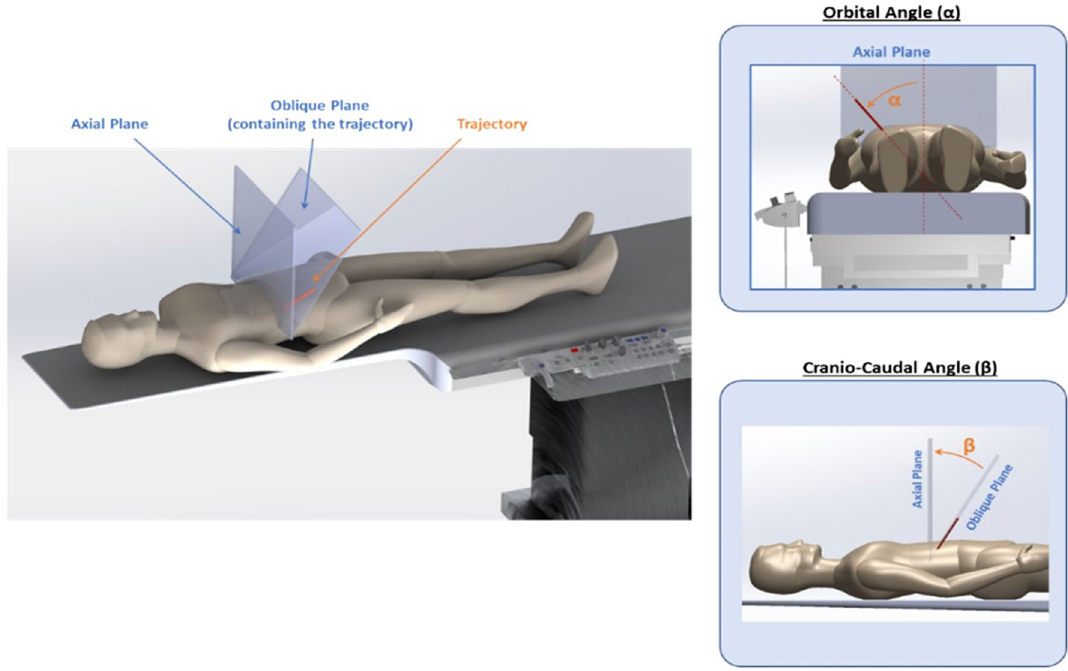
Figure 7. Definition of orbital and cranio-caudal angulations.